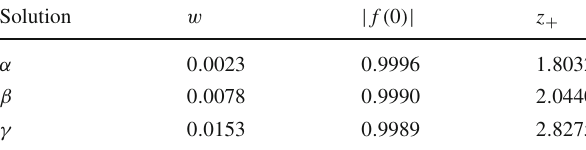
Table 3 Solutions for the elliptic class in seven dimensions